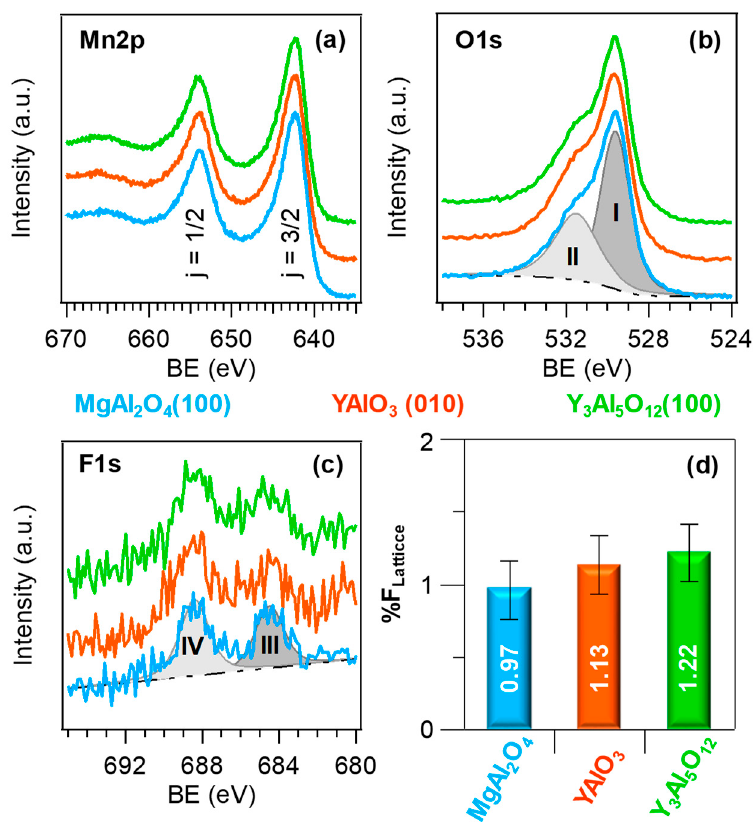
Figure 1. Core level Mn2p ( a ), O1s ( b ), and F1s ( c ) signals, and lattice fluorine content ( d ), for manganese dioxide systems deposited on different substrates.